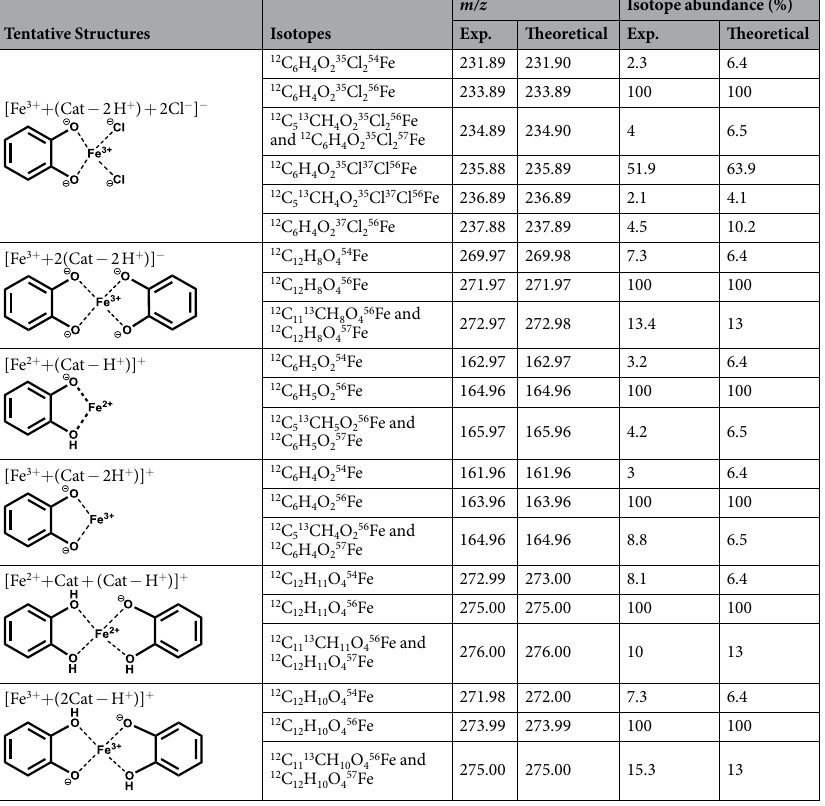
Table 2. Tentative structures of iron-catechol complexes with corresponding experimental and theoretical mass-to-charge ratios ( m/z ) and isotope